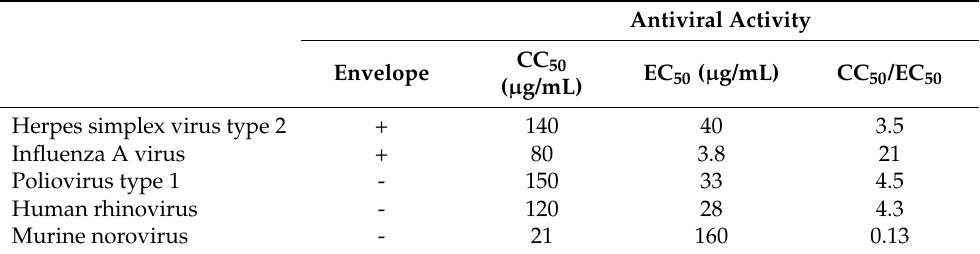
Table 1. Antiviral activity of grape seed